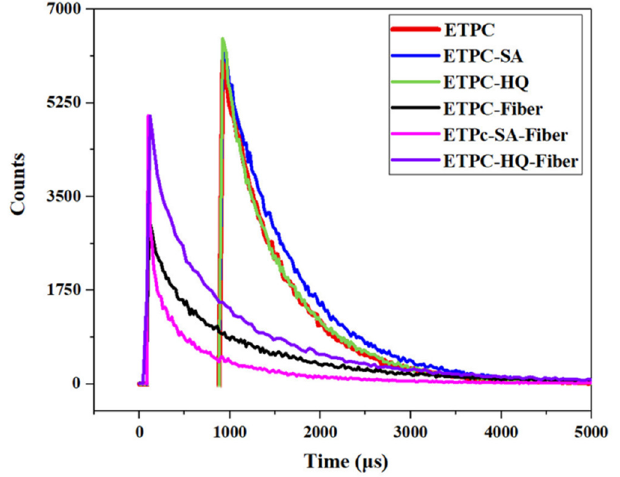
Figure 10. Luminescence decay curves: ETPC (red), ETPC-SA (blue), ETPC-HQ (green), ETPC fiber (black), ETPC-SA fiber (magenta), and ETPC-HQ fiber (violet) upon excitation at 365 nm and emission at 613 nm. Table 2. Data of fluorescence lifetime and quantum yield upon excitation at 365 nm and emission at 613 nm.